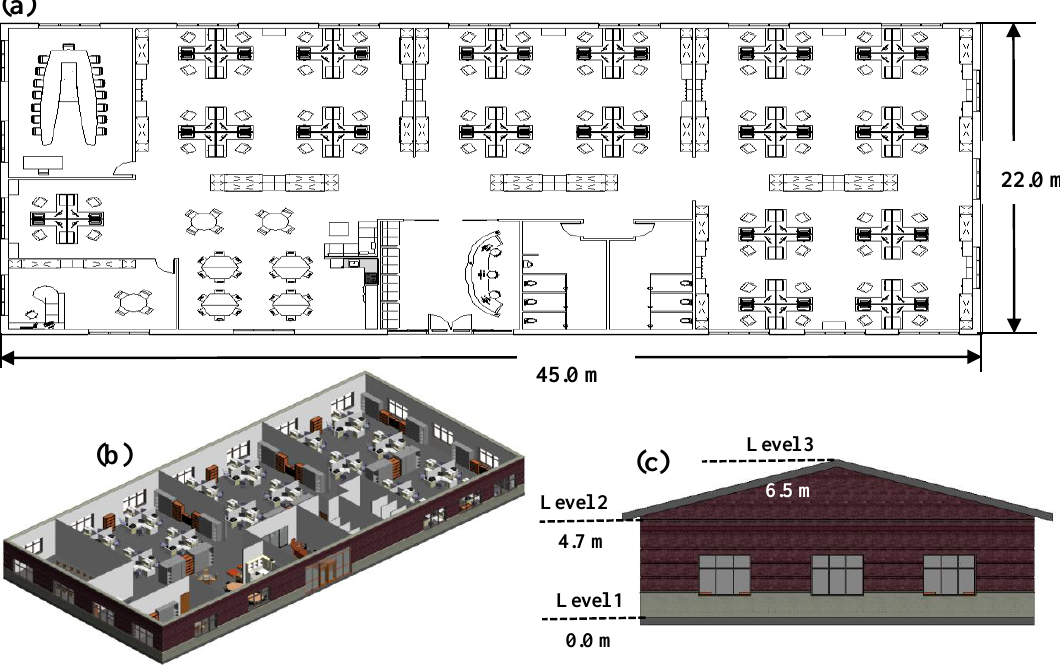
Figure A13. F14 archetype plans and sections: ( a ) Plan view; ( b ) 3-D views for the office building; (c) Side view.